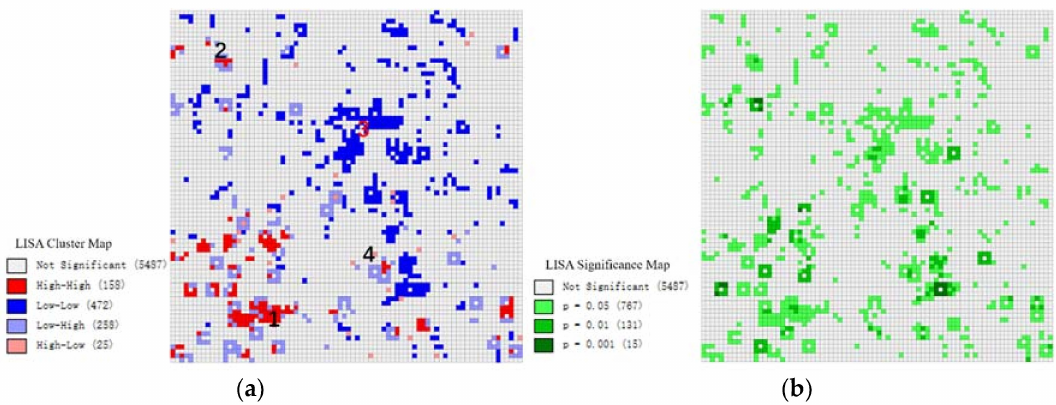
Figure 5. ( a ) The local indicator of the spatial association cluster pattern of the difference between SUM weekday(i) and SUM weekend(i) ; ( b ) the local indicator of spatial association significance map ( p < 0.05).